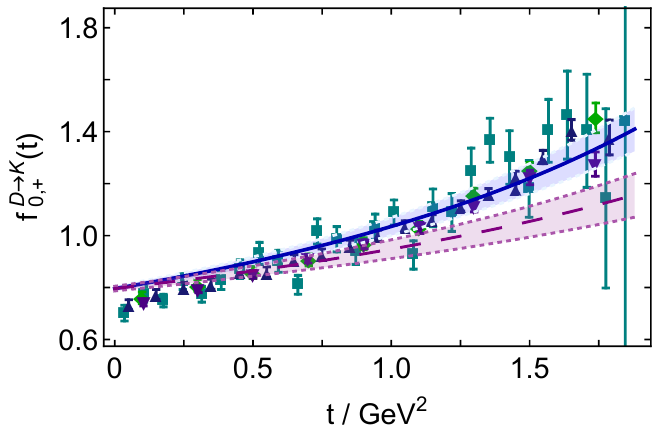
Figure 20. D → K transition form factors. f + —solid blue curve; f 0 —long-dashed purple curve; like-coloured shaded bands—associated SPM uncertainty in each case. Data: cyan squares [380]; green diamonds [381]; dark-blue up-triangles [382]; indigo down-triangles